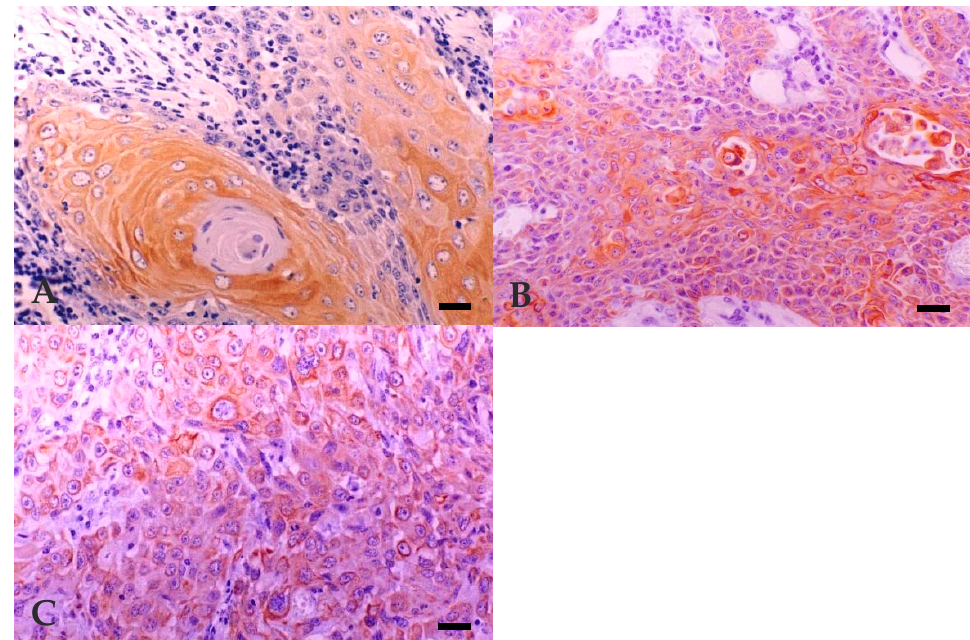
Figure 2. Expression of cytokeratin marker MNF116 in BOSCC. ( A ) WD: cytoplasmic diffuse and intense reaction—more intense in well ‐ differentiated keratinocytes. Bar, 25 μ m. ( B ) MD: cytoplasmic diffuse and intense reaction—more intense in well ‐ differentiated keratinocytes. Bar, 25 μ m. ( C ) PD: cytoplasmic diffuse and intense reaction in most neoplastic cells, including those of pleomorphic areas. Bar, 25 μ m. Immunohistochemistry using avidin ‐ biotin complex method, Mayer’s Hematoxylin counterstain.